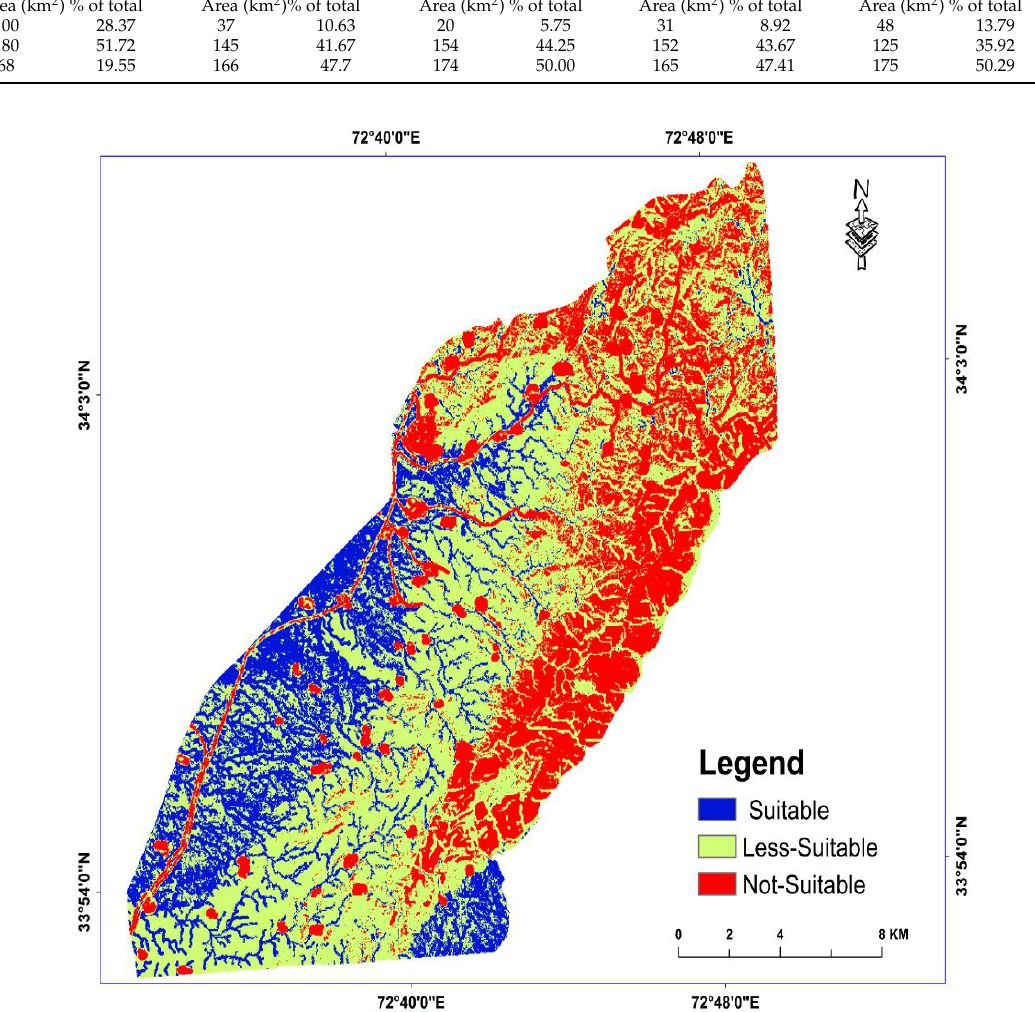
Figure 9 . Area suitability for rainwater harvesting. Figure 9. Area suitability for rainwater